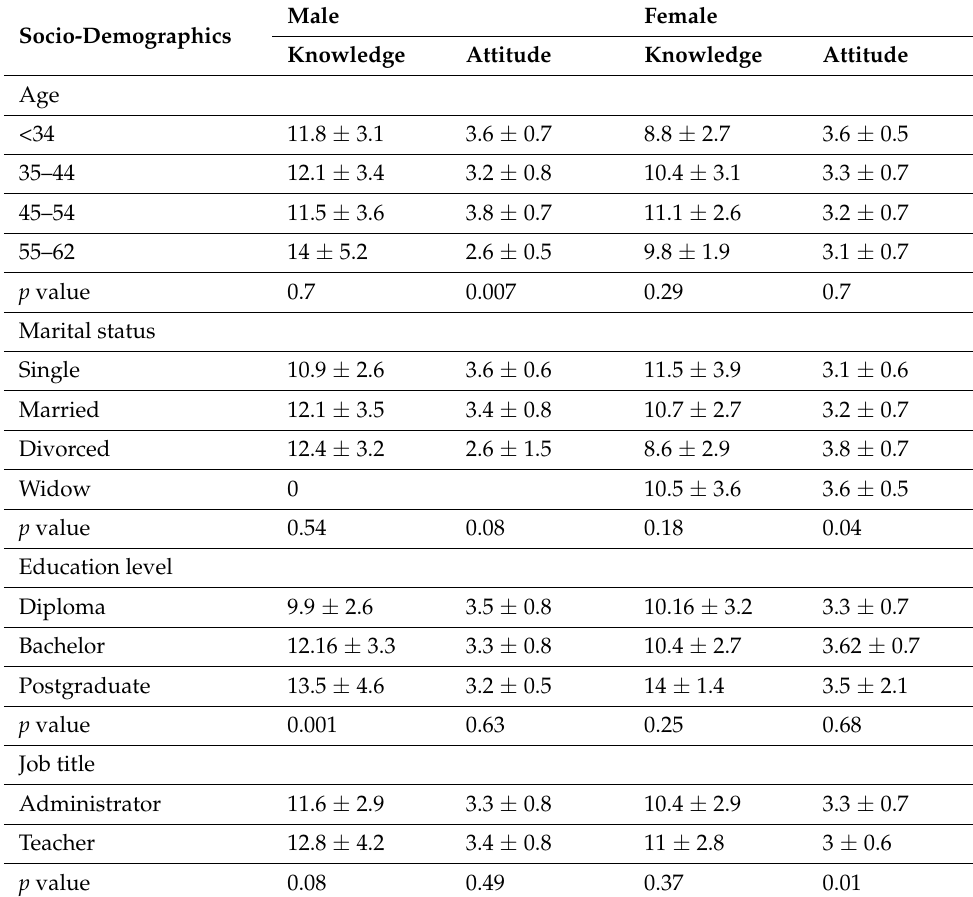
Table 5. Association between knowledge, and attitude scores toward vitamin D and selected socio- demographics for health educators stratified by